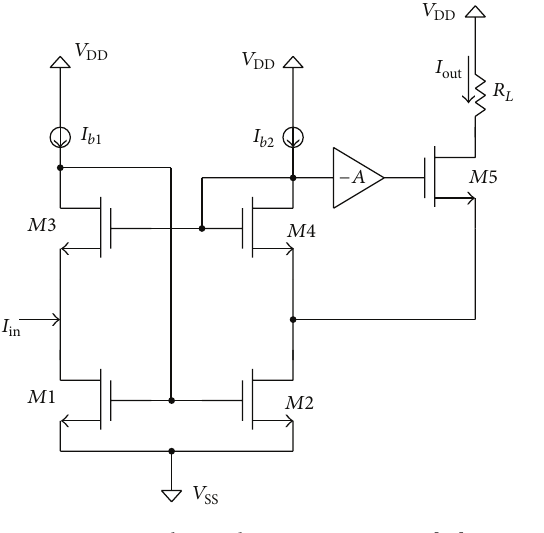
Figure 6: High compliance current mirror [19].